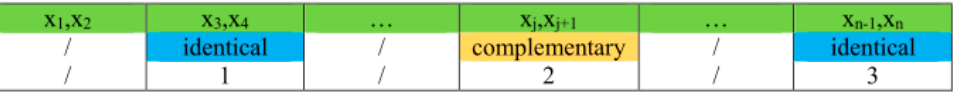
Figure 3. Double-matching constraint. The bases are connected according to the 5 ′ -> 3 ′ end arrange- ment. The first line of data in the figure denotes sequence x with a base number n ; two consecutive bases are a combination, divided into n /2 base combinations, such as ( x 1 , x 2 ) , assuming that ( x 1 , x 2 ) is the original base combination and looking for the base combination associated with it in the sequence. The second row of data indicates the relationships between the current base combination and ( x 1 , x 2 ) ; “identical” means the two combinations are identical, and “complementary” means the two combinations are complementary. The third row of data denotes the number of combinations in the sequence that are identical or complementary to ( x 1 , x 2 ) , that is, the count in Equation (14). There are four combinations that are related, including the combination ( x 1 , x 2 ) . Therefore, the bases of one (cid:16) (cid:17) x j , x j + 1 of the combinations ( x 3 , x 4 ) , , and ( x n − 1 , x n ) are selected for replacement, and then it is is selected as the original base combination, scanning continues, and the above steps are